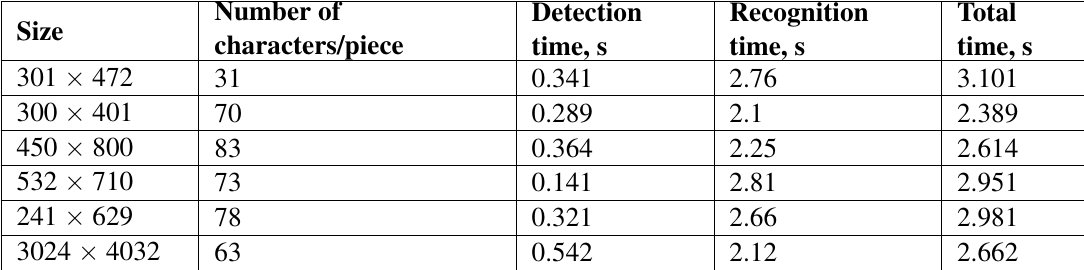
Fig. 5 SVT partial text detection results. Table 2 Partial image processing